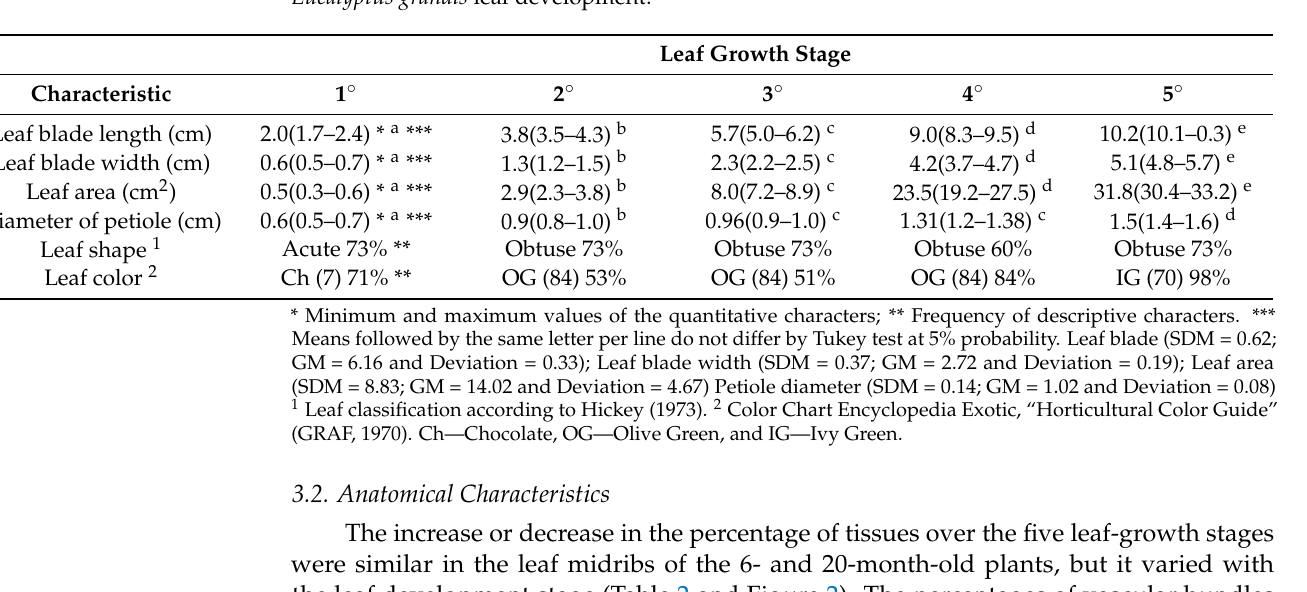
Table 1. Differentiation of leaf stages based on quantitative (length and width), area, diameter of the petiole and qualitative (shape and color) factors for the five phenological development stages of Eucalyptus grandis leaf